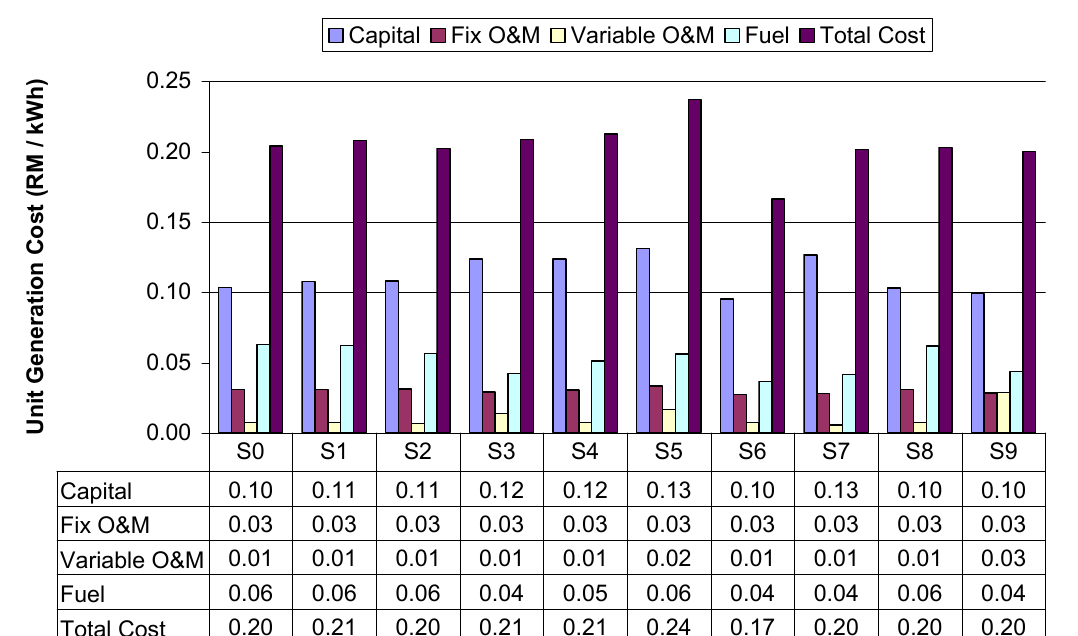
Figure 7. Unit electricity cost for all the scenarios